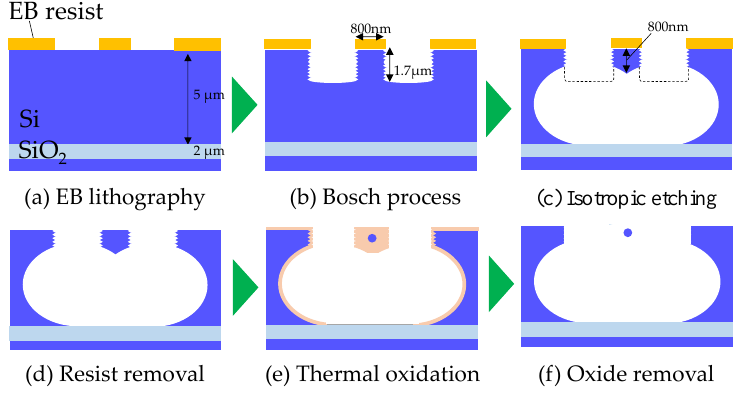
Figure 3. SiNW fabrication process. For further thinning, steps ( e , f ) are repeated twice.